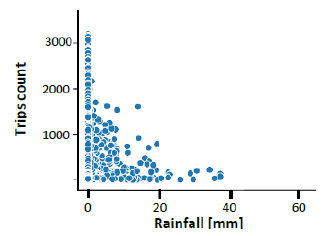
Figure 13. Rainfall vs use of the service